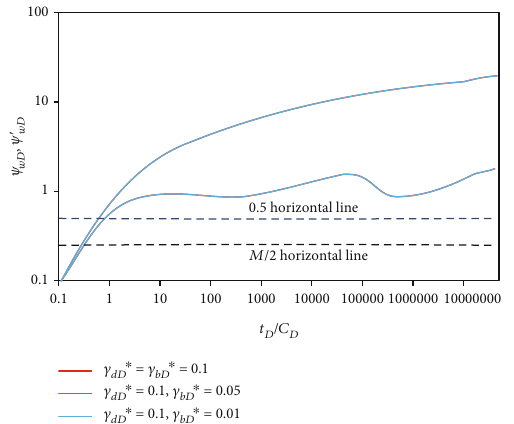
Figure 13: Well test curves of the pressure buildup well test under di ff erent skin factors.